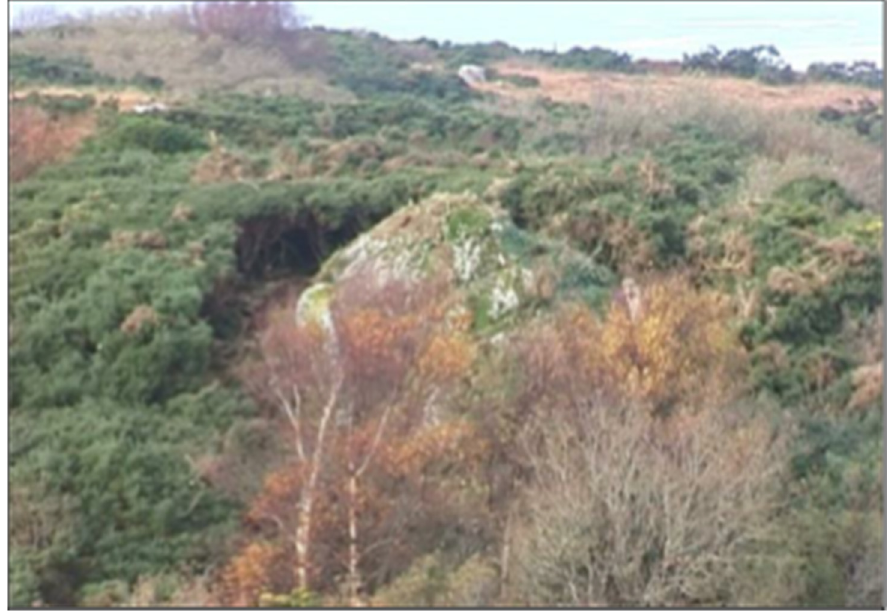
Figure 15. Kilkenny Breccia Pipe, County Donegal: inaccessible site in thick gorse.